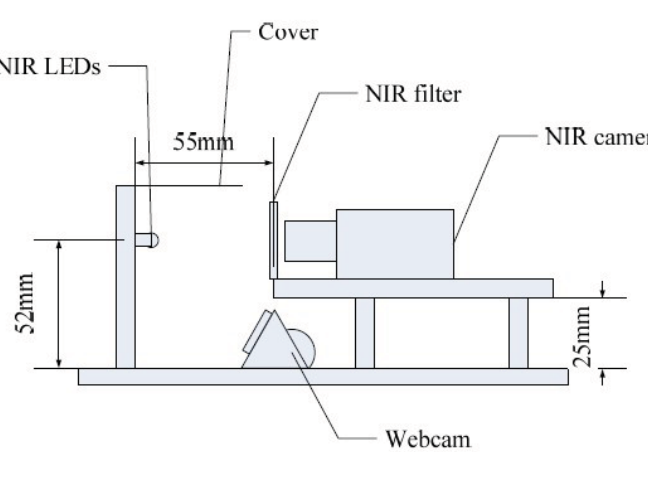
Figure 7. The imaging